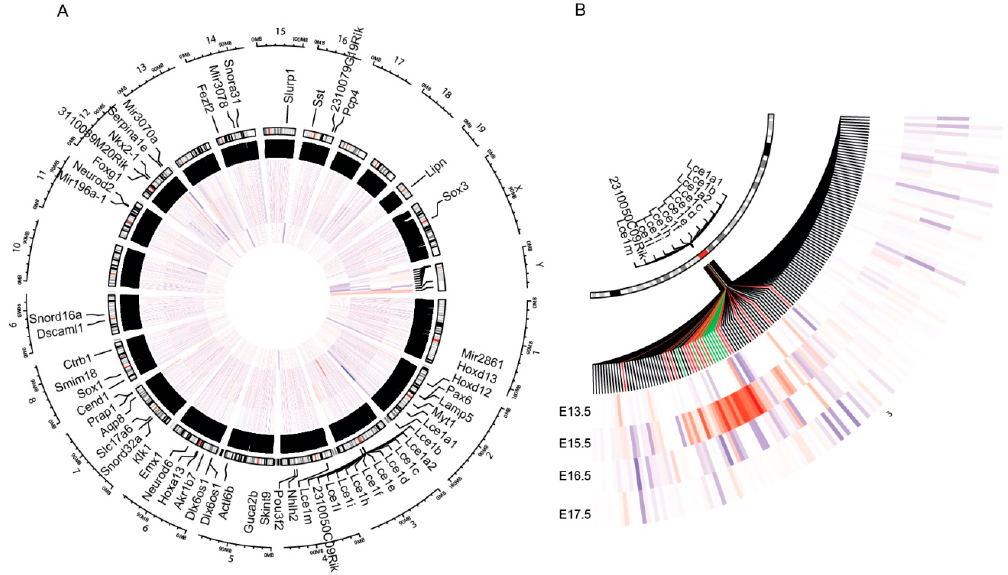
Figure 1. Promyelocytic leukemia (PML) regulates epidermal di ff erentiation complex (EDC)